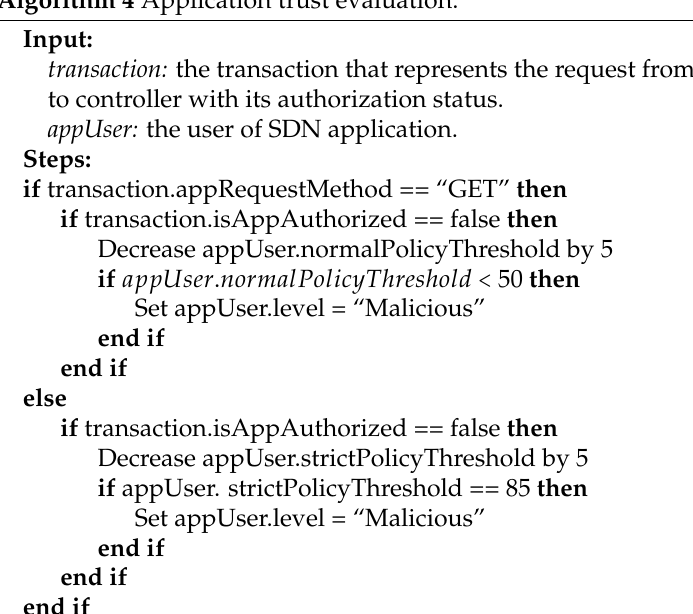
Algorithm 4. The interactions between an application and SDN controller can be classified into reading network status and writing network permissions [13]. Algorithm 4 Application trust